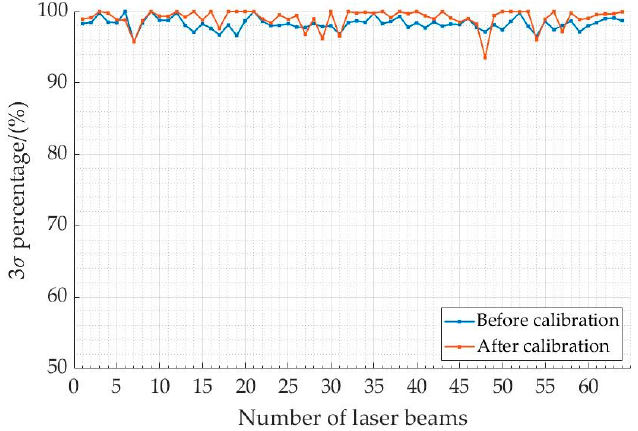
Figure 14. The percentage of points within the 3 σ confidence interval for the distance standard deviation from the point to the calibration plane. Table 1. The mean percentages of P2P-D for 64 laser beams according to 3 σ criterion.